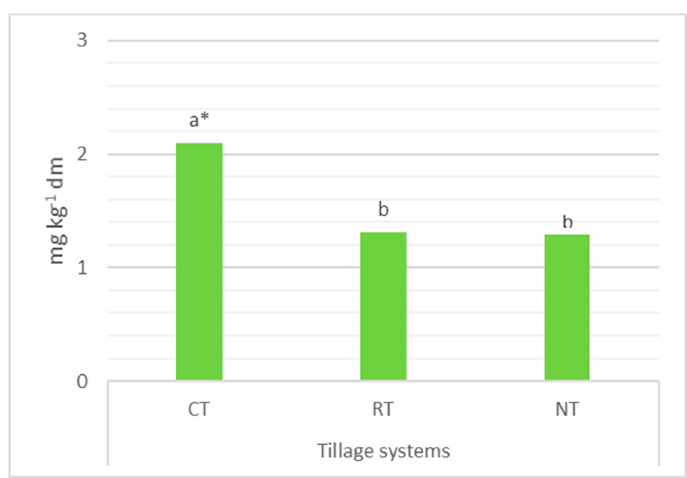
Figure 6. Content of N-NO 3 in the 0–25 cm soil layer depending on the tillage system (average of 2014–2016). * a—Means denoted with the same letters do not differ significantly, p < 0.05.